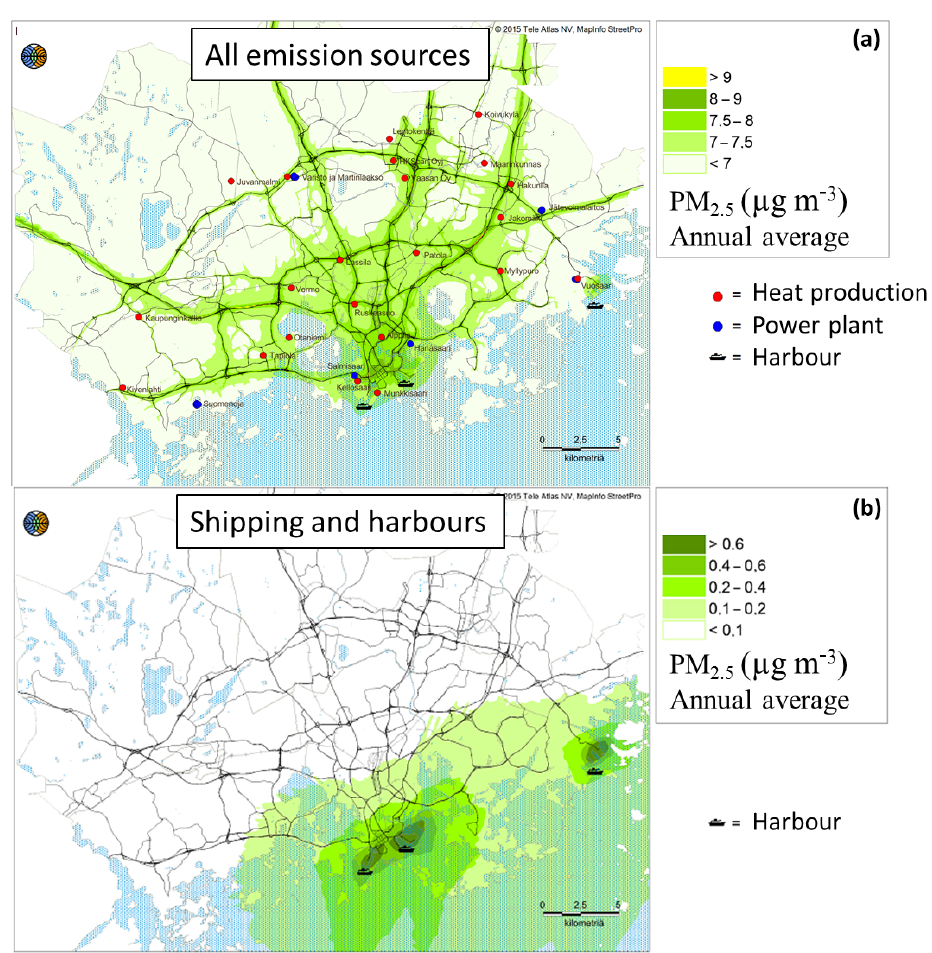
Figure A1. (a) The predicted 3-yearly average concentrations of PM 2 . 5 originated from the regional background and all source categories, except for small-scale wood combustion, and (b) the corresponding contribution for only shipping and harbour activities in the Helsinki Metropolitan Area during 2012–2014 (slightly revised from Hannuniemi et al., 2016). The locations have also been indicated for the three major harbours, and for major power plants and heat production